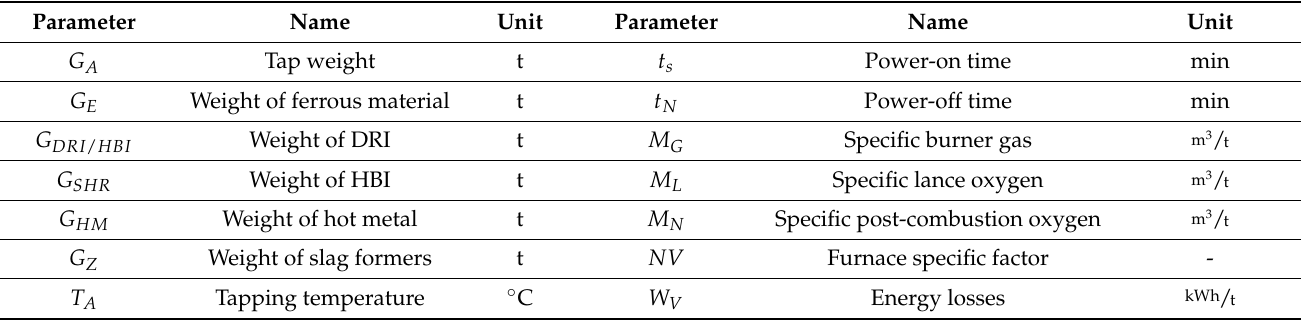
Table 1. Parameters of the Köhle